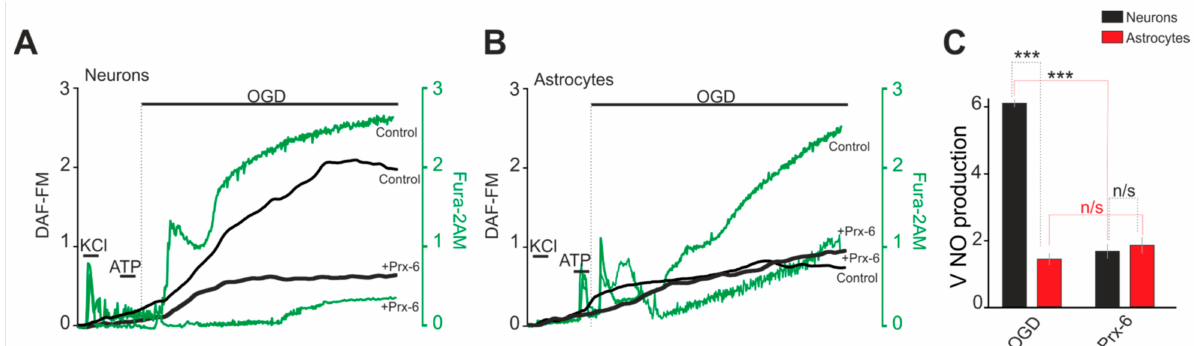
Figure 3. Effects of antioxidant enzyme Prx-6 on OGD-induced NO production. ( A , B ) Registration of NO production and Ca 2+ -responses in the neurons ( A ) and the astrocytes ( B ) during OGD (40 min) depending on a 24-h incubation of the cell cultures with Prx-6 (100 µ M). Average curves plotted according to data on several dozen cells are represented. ( C ) Effect of the Prx-6 under study on the rate of NO production in hippocampal neurons and astrocytes. The average rates of NO production within the interval from the point of OGD onset to the end point of the experiment are represented. Short-term applications of 35 mM of KCl and 10 µ M of ATP were used to detect neurons and astrocytes, respectively. Statistical significance was assessed using paired t -test. n/s—data not significant ( p > 0.05), *** p <